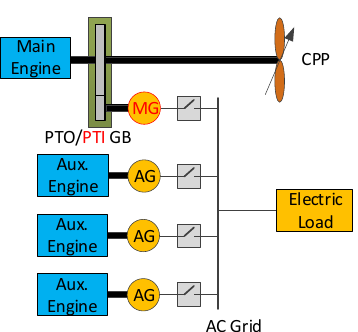
Figure 1. Layout of the updated chemical tanker propulsion system and electric generating system. Table 1. Ship particulars of the benchmark chemical tanker.